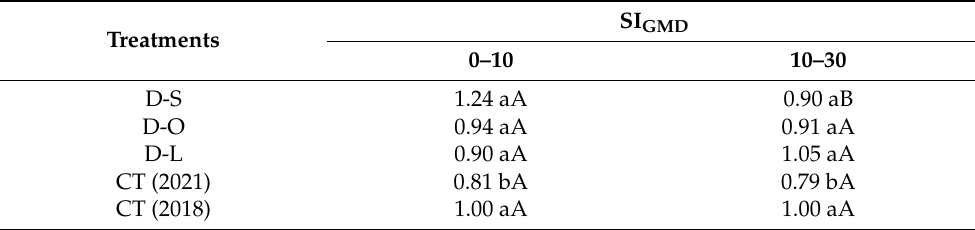
Table 1. GMD sensitivity index (SI GMD ) in the 0–10, and 10–30 cm layers.